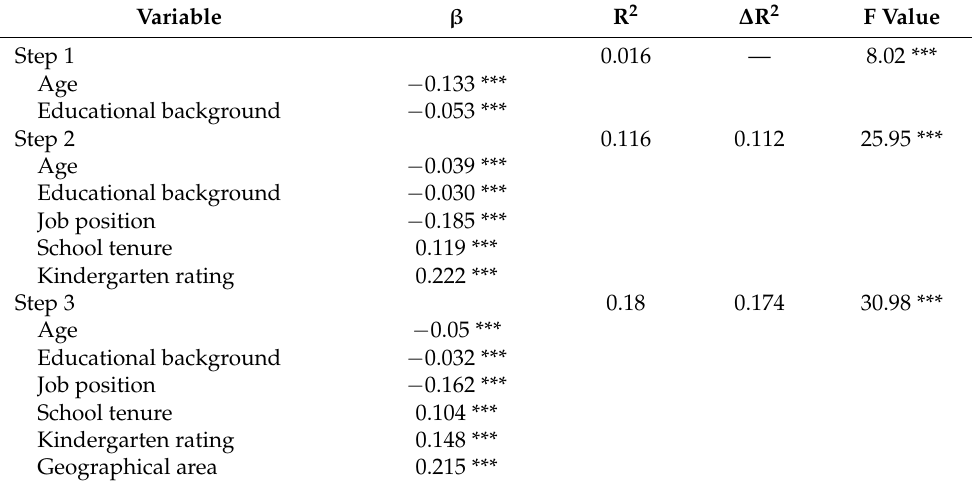
Table 5. Summary of hierarchical regression analysis predicting teacher